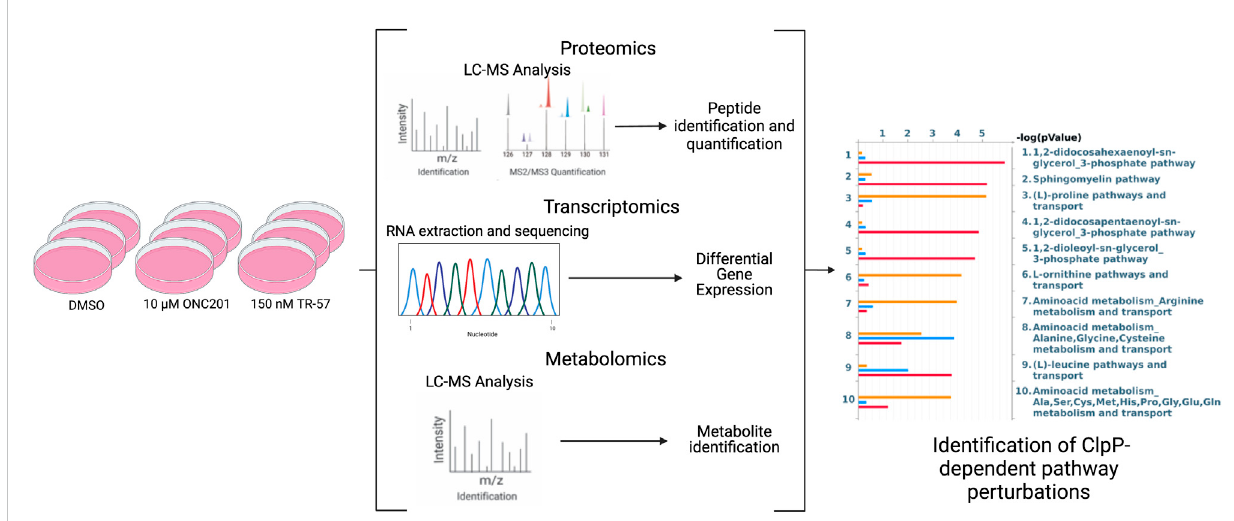
FIGURE 1 Schematic of multi-omics data collection and analysis of triple-negative breast cancer cells. SUM159 cells were treated with 0.1% DMSO, 10 µM ONC201, or 150 nM TR-57 and samples were collected and prepared for transcriptomics, metabolomics, and proteomics analyses using appropriate methods. Datasets were then analyzed individually using standard methods and as a combined multi-omics dataset using MetaCore. N =